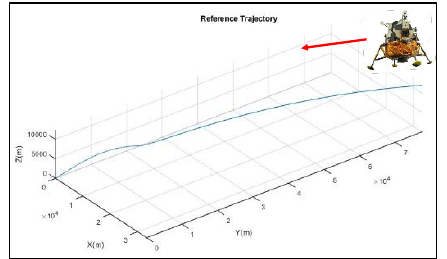
Figure 11. The reference trajectory in local level frame